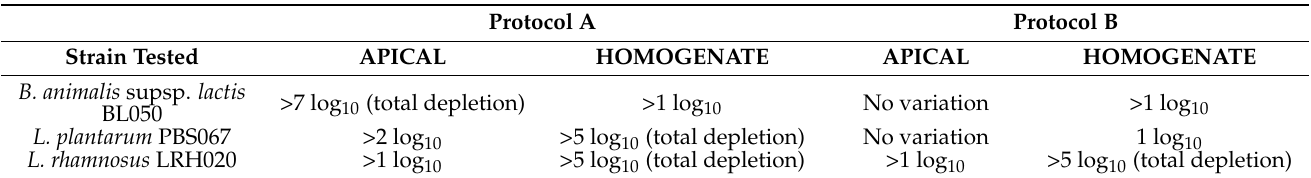
Table 6. The visual check of precipitate was expressed as cluster quantity ( − , +, ++, +++) and the flocculation time was recorded in minutes (min). Table 5. Results of viable count obtained by the decrease in E. coli viability on HBE, expressed as log 10 variation with respect to the colonized control, for both